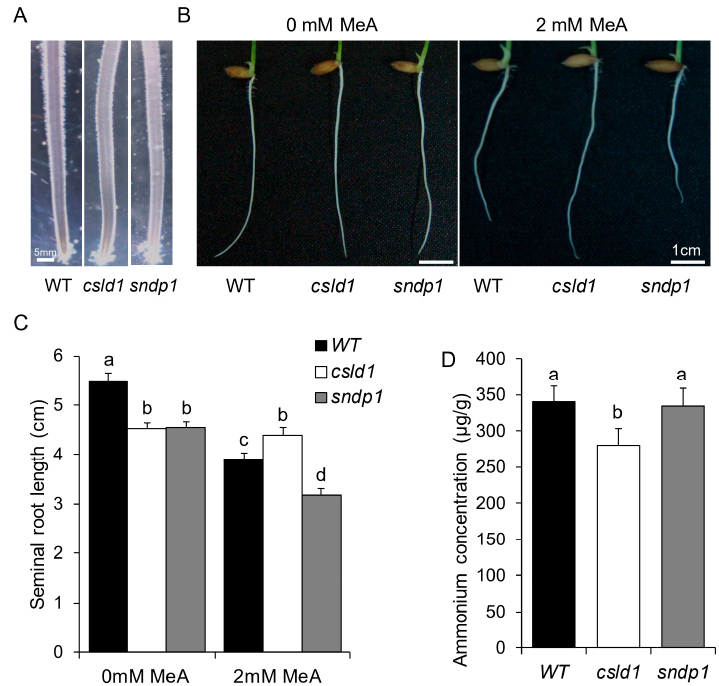
Figure 7. Differences in root hair length did not affect the nitrogen concentration in roots. ( A ) Sem- inal roots of wild-type, csld1 , and sndp1 three days after germination. ( B ) Three-day-old seedlings grown in MS-NH 4 NO 3 with or without Methyl-ammonium (MeA). ( C ) seminal root lengths of wild- type, csld1 and sndp1 seminal roots with or without methyl-ammonium (MeA) and ( D ) ammonium error of means ( n = 8–12). Different letters indicate significant differences between groups according to Tukey’s HSD test ( p < 0.05).